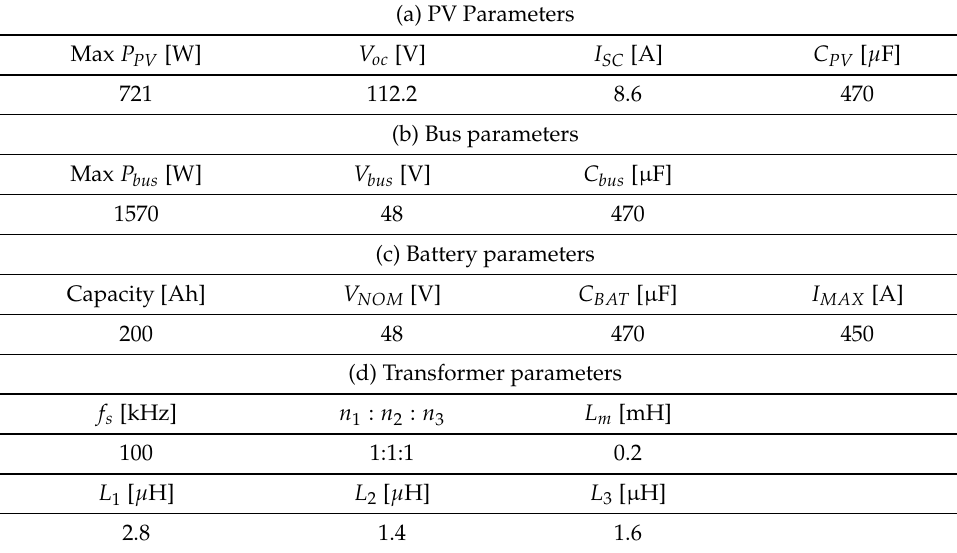
Table 1. Architecture parameters.